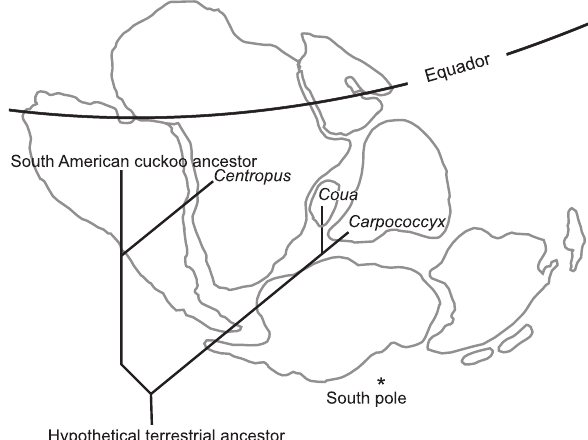
Figure 4. Hypothesis of early vicariance distribution of the cuckoos in the Early